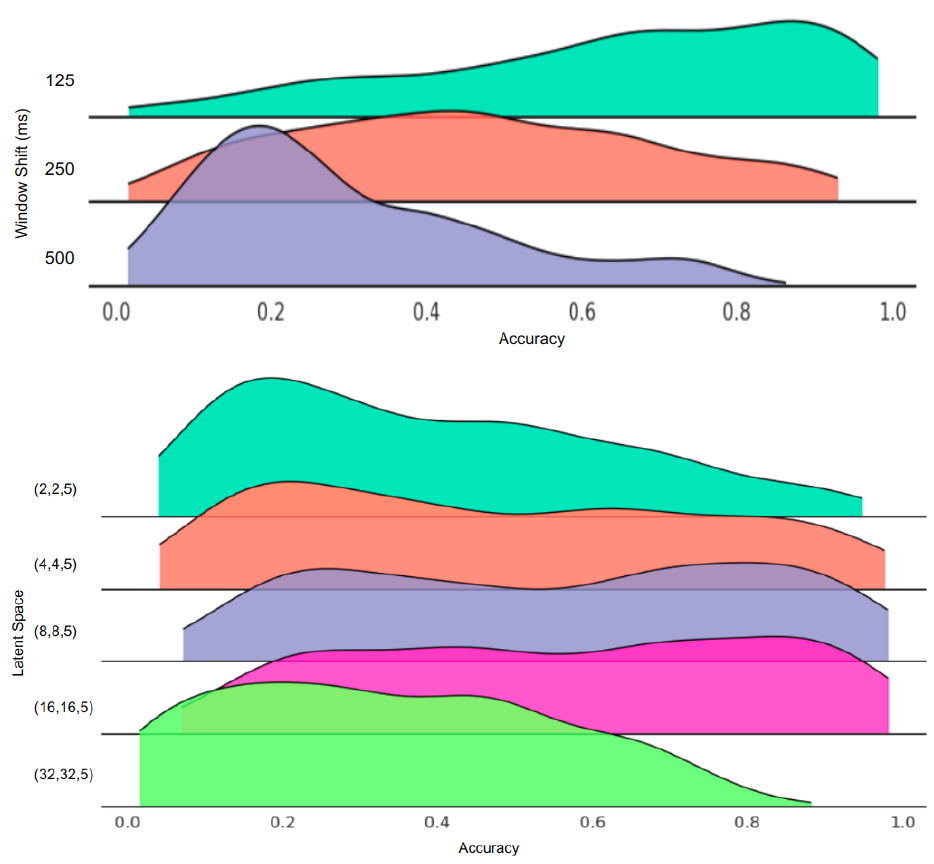
Figure 9. Accuracy distribution of the classification models for all the participants across window length, window shift, and latent space.